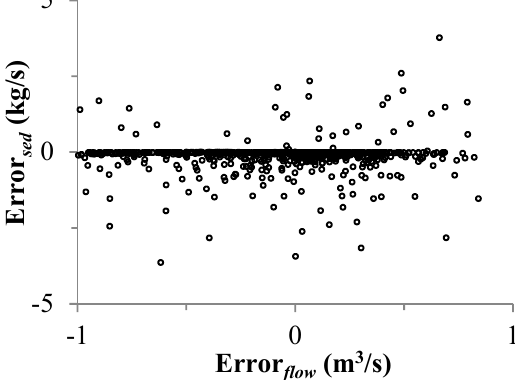
Figure 9. Diagnosis of the independence between flow and sediment model residuals after the BC transformation for the BC-GED approach.